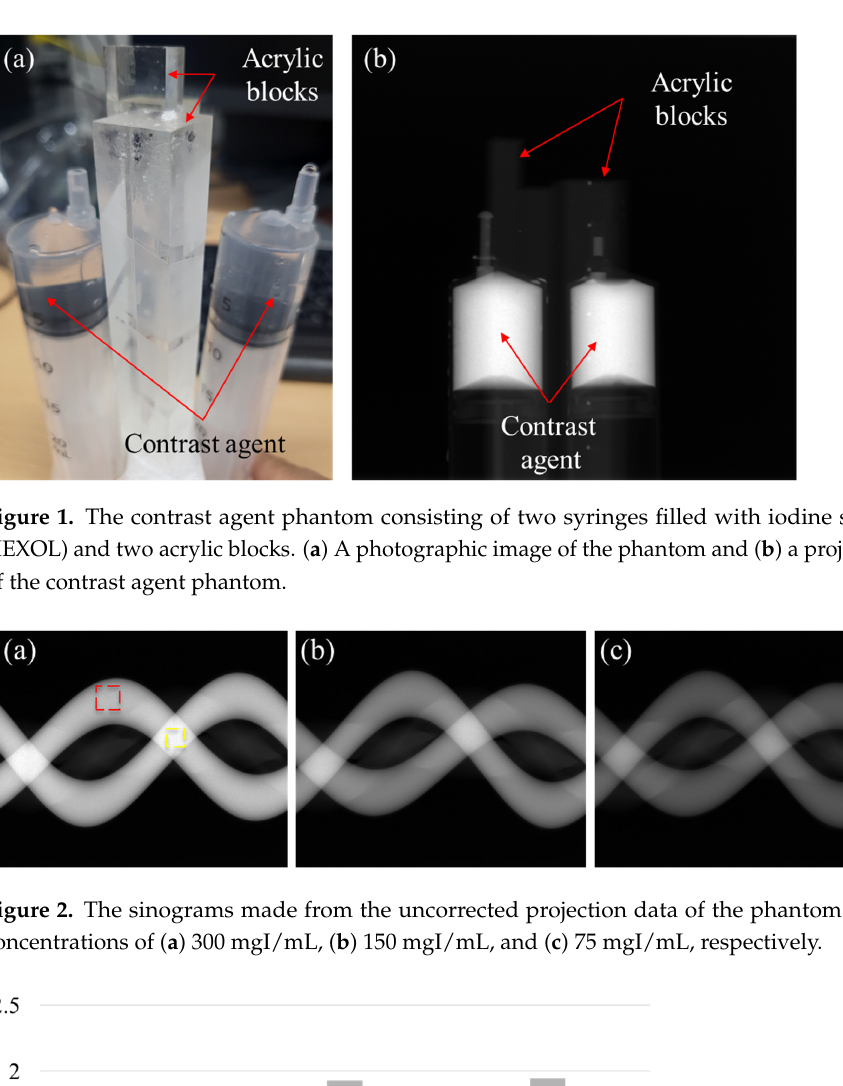
Figure 1. The contrast agent phantom consisting of two syringes filled with iodine solution (IO- HEXOL) and two acrylic blocks. ( a ) A photographic image of the phantom and ( b ) a projection im- age of the contrast agent phantom.